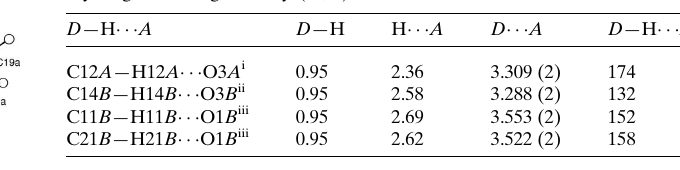
Table 1 Hydrogen-bond geometry (A˚ , (cid:3) ).